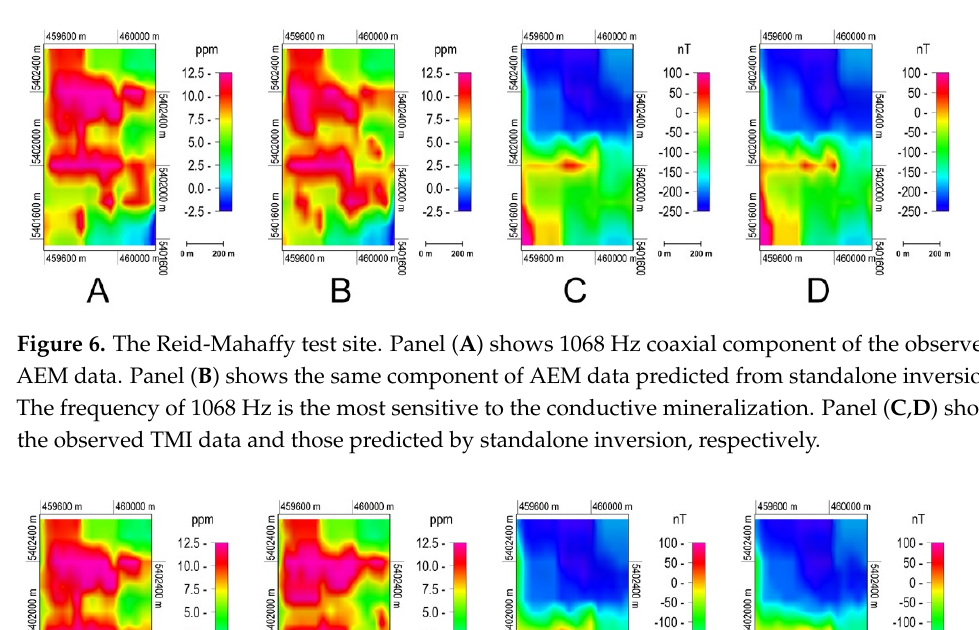
Figure 5. The Reid-Mahaffy test site. Panel ( A ) shows the 3D conductivity (S/m) model produced from joint inversion with Gramian-based structural constraints. Panel ( B ) presents the 3D suscepti- bility (SI) model produced from Gramian joint inversion. The red arrow is easting, and the green arrow is northing. The location of the borehole is shown by short white line. The yellow cylinder on the borehole indicates the confirmed zone of mineralization.